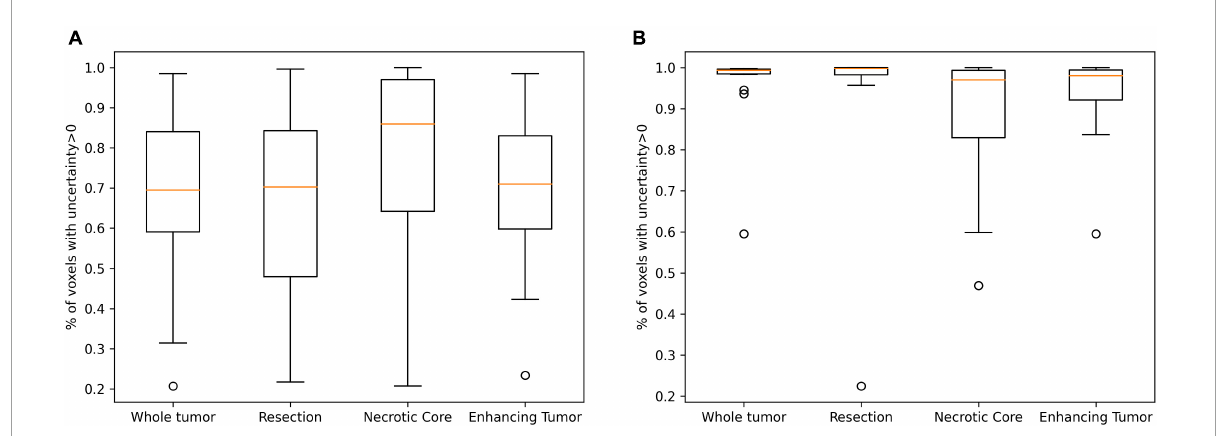
FIGURE6 A comparison of uncertainty values of high ( A ; Dice > 0.5) and low ( B ; Dice < 0.5) accuracy segmentations. Lower accuracy segmentations were associated with higher uncertainty